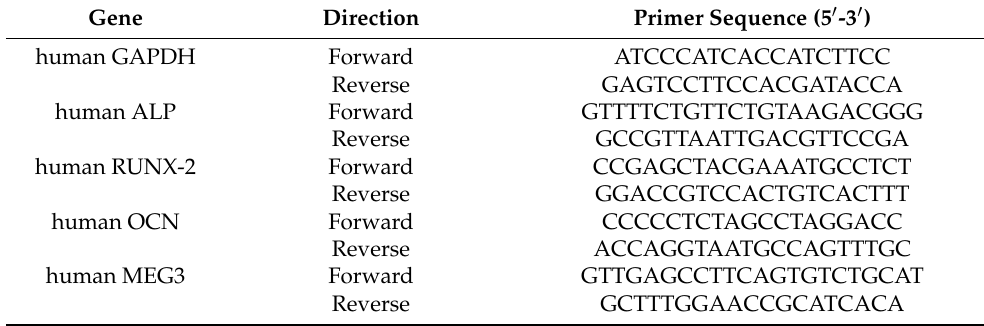
Table 1. Quantitative real-time polymerase chain reaction primer sequences.